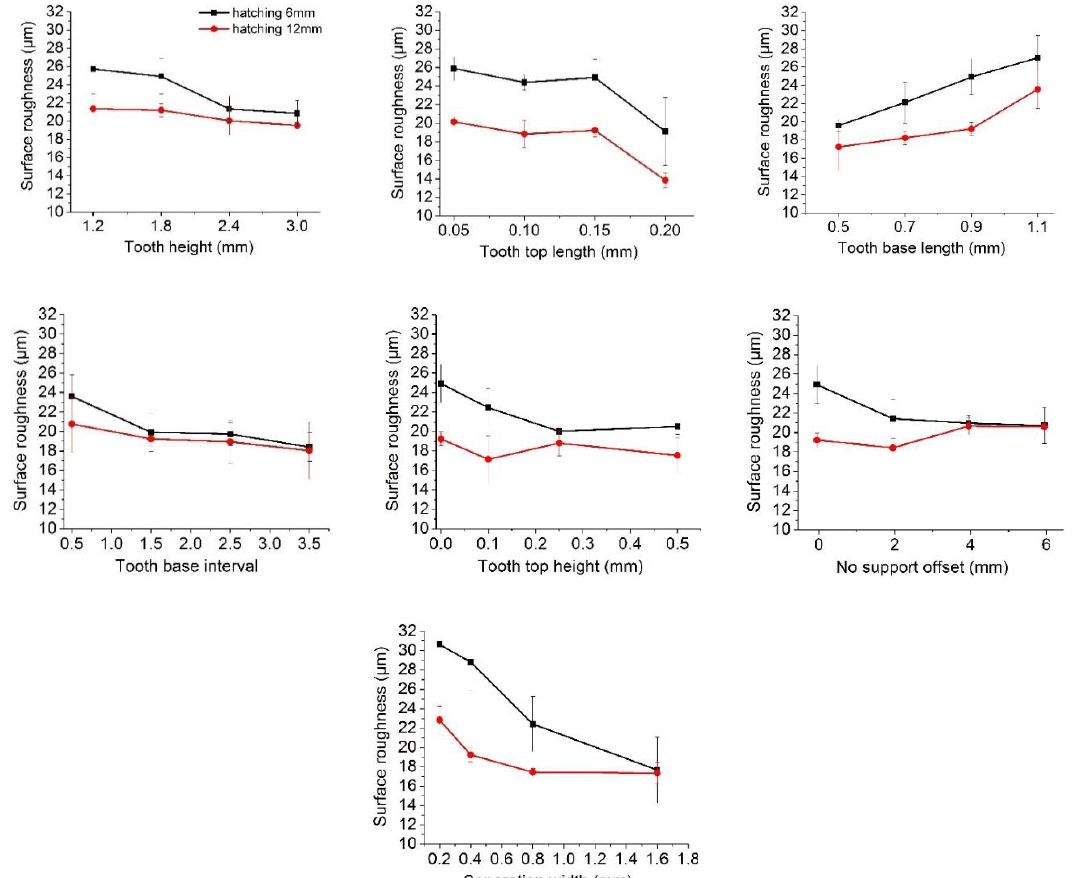
Figure 12. E ff ect of support parameters on surface Figure 12. Effect of support parameters on surface roughness.